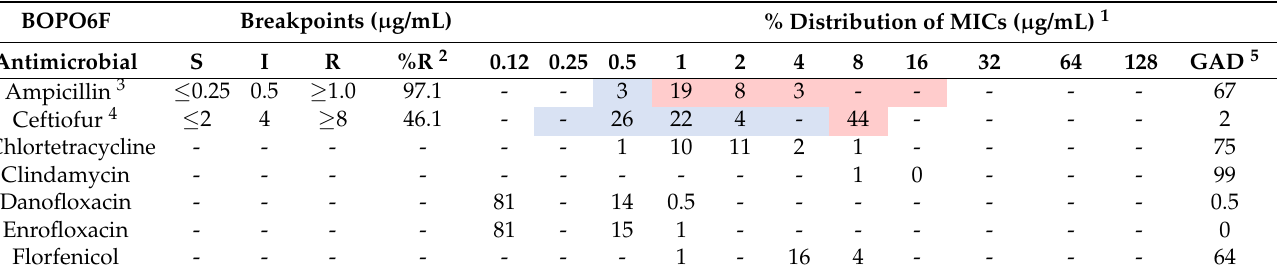
Table 2. Distribution of minimum inhibitory concentration (MIC) and resistant for S. Dublin iso- lates (n = 247) by individual drug for the BOPO6F panel. Highlighted areas in blue correspond to susceptible/intermediate classification, and the red highlighted area corresponds to resistant classification. Epidemiological cut-off points (ECOFFs) for antimicrobial drugs that fulfilled criteria for this approach are marked with a yellow highlighted asterisk * (95% endpoint criteria) and green highlighted asterisk * (99% endpoint